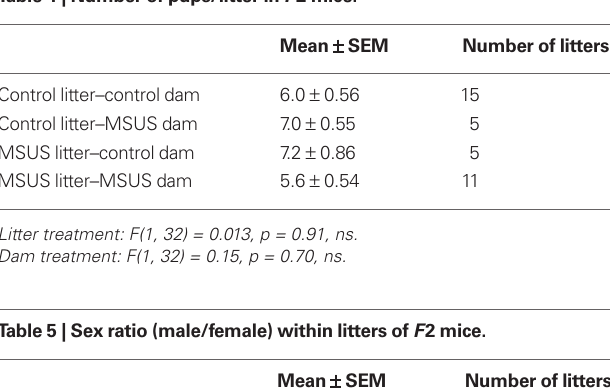
Table 4 | Number of pups/litter in F 2 mice.